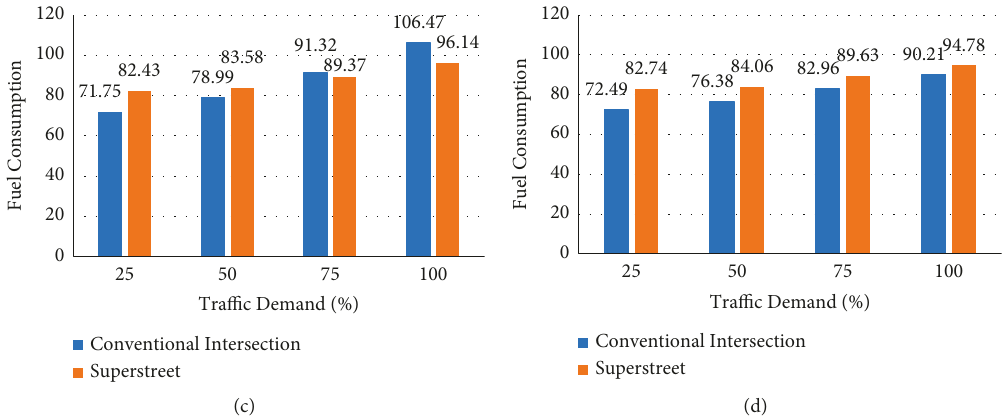
Figure 14: Average fuel consumption(ml) comparison of CAVs between the conventional intersection and superstreet. (a) IDM. (b) IDM with platooning. (c) IDM with trajectory planning. (d) IDM with platooning-based trajectory planning.